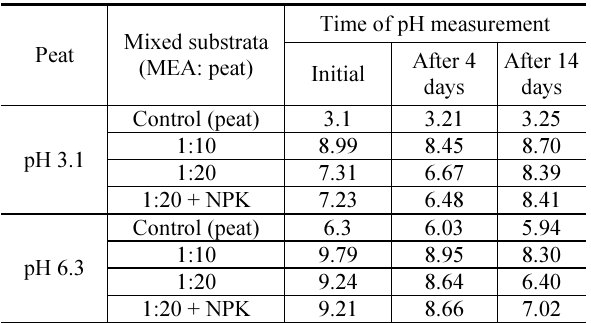
Table 3. Changes of pH KCl of peat and peat: MEA mixed